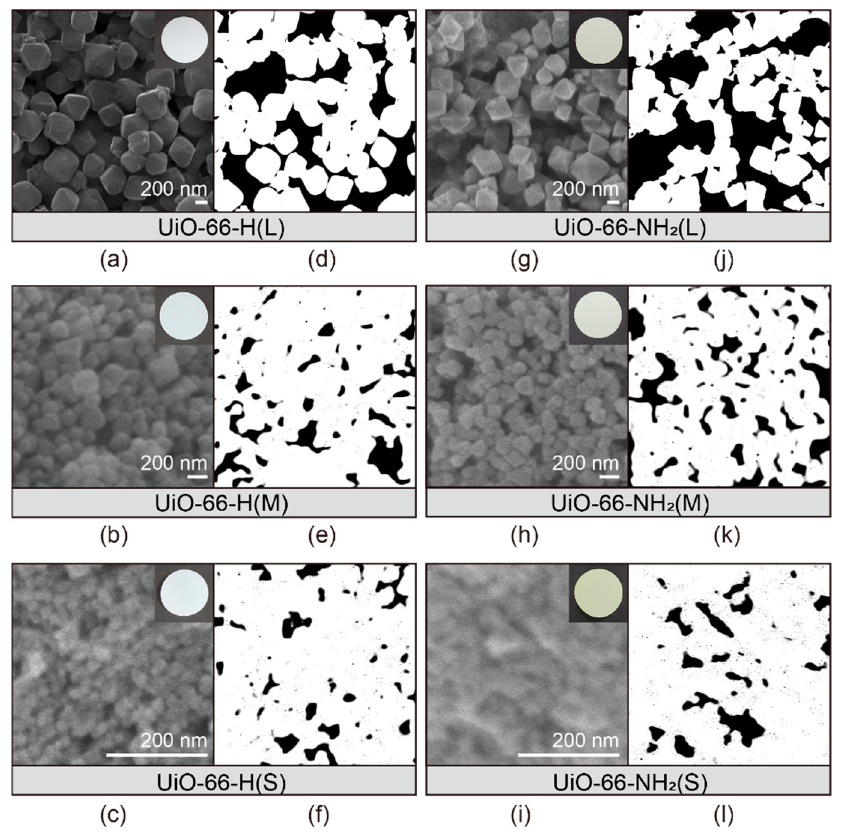
Figure 4. Morphology of MOF-coated separators and their interparticle spaces. SEM images depicting morphology of MOF-coated separator surfaces for: ( a – c ) UiO-66-H(X) and ( g – i ) UiO-66-NH 2 (X) samples. The images after threshold adjustment with: ( d – f ) UiO-66-H(X) and ( j – l ) UiO-66-NH 2 (X) coated